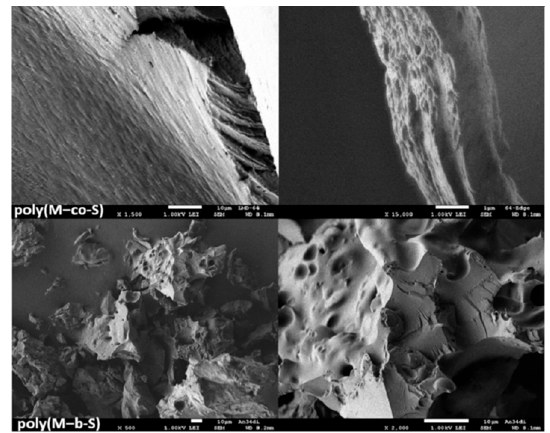
Figure 6. Scanning electron microscope (SEM) of poly(M − co -S) from run 14 of Table 2 and poly(M − b-S) from run 21 of Table 2.